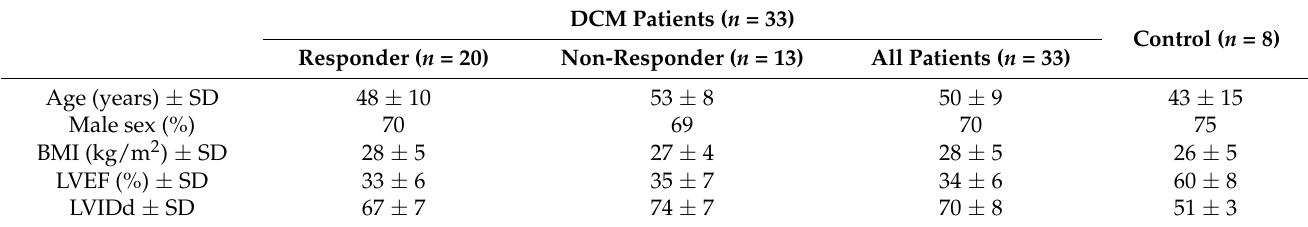
Table 2. Characteristics of individuals in GSE19303.